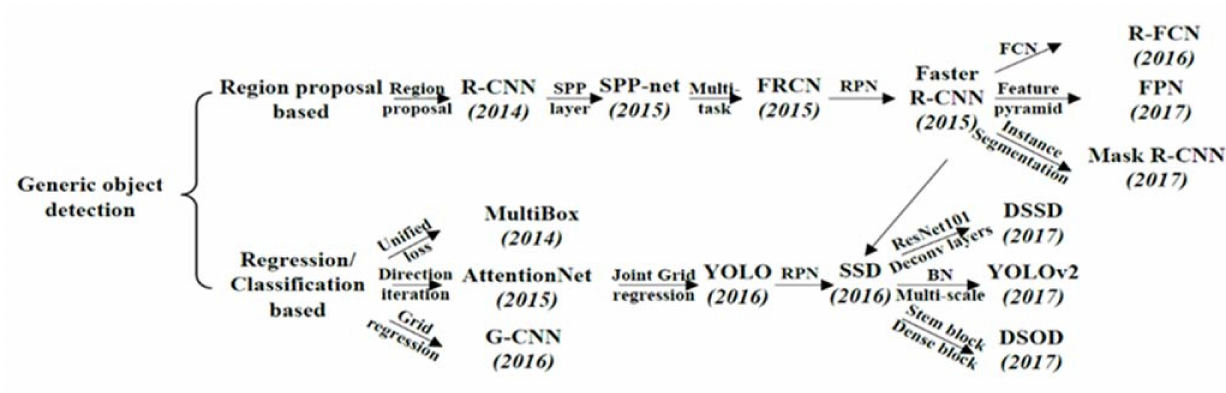
Figure 3. Object detection: one-stage (region proposal based)/two-stage (regression/classification based)